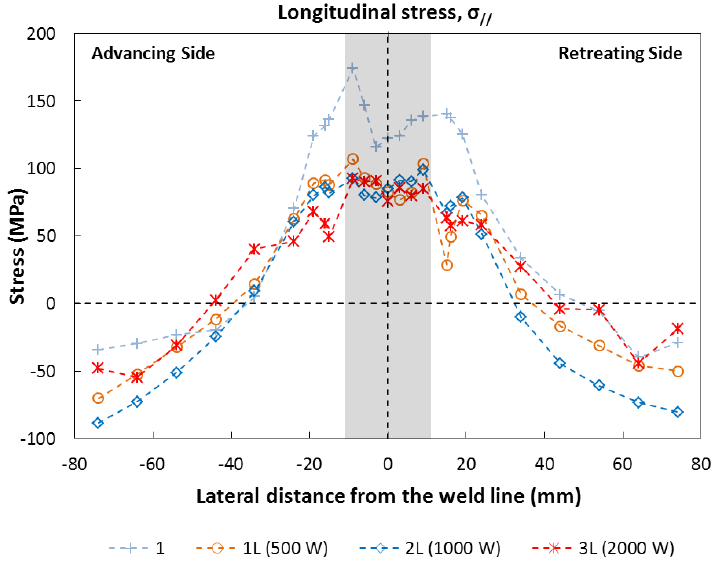
Figure 14. Longitudinal residual stresses along the centerline.